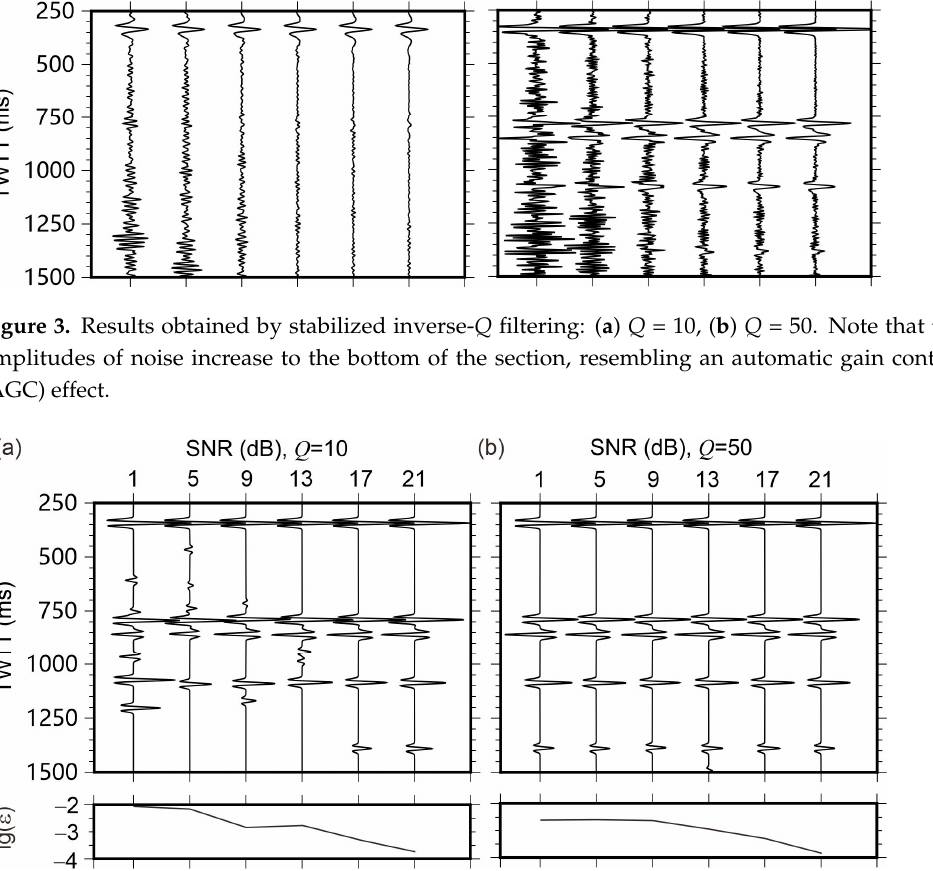
For weaker attenuation with Q = 50, inverse- Q filtering recovered the first four re- flections at almost all SNRs. However, at low SNR levels, the inverse- Q filter still over- amplified the noise (for example, for SNR < 13 dB). By contrast, the ITD not only recovered the reflections but also filtered out the noise, which helped improve the images (Figure